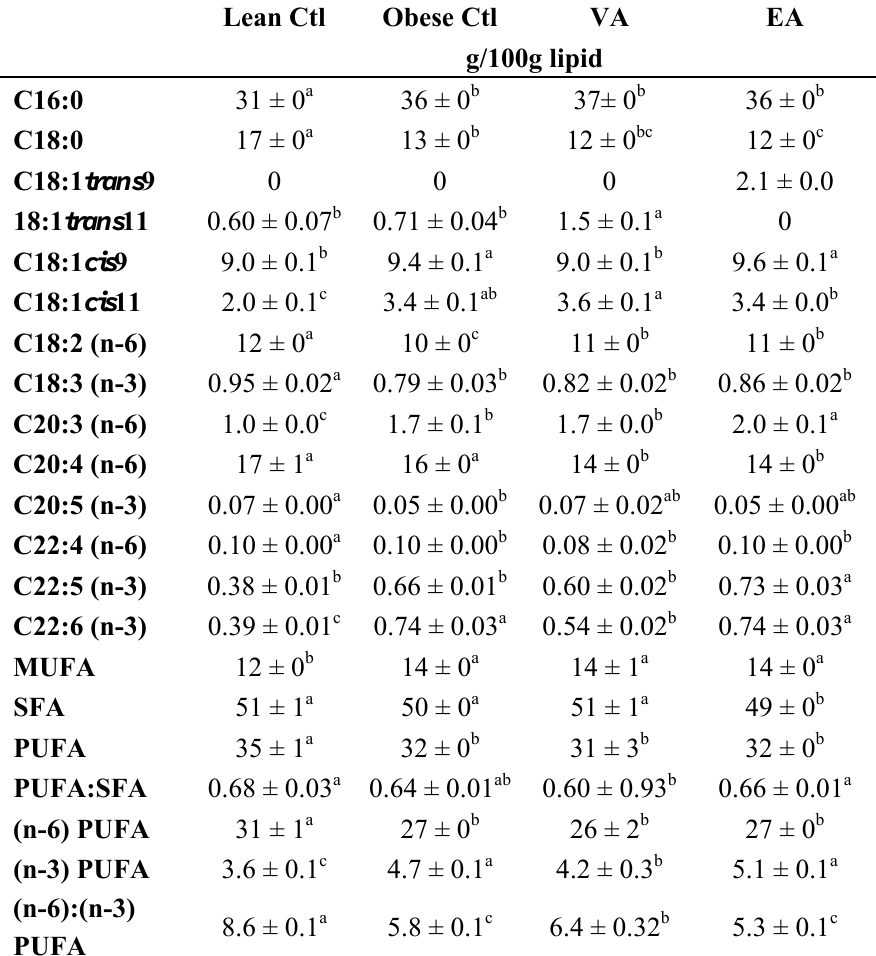
Table 3. Splenocyte phosphatidylcholine fatty acid composition of lean rats and obese JCR:LA- cp rats fed Ctl, VA or EA